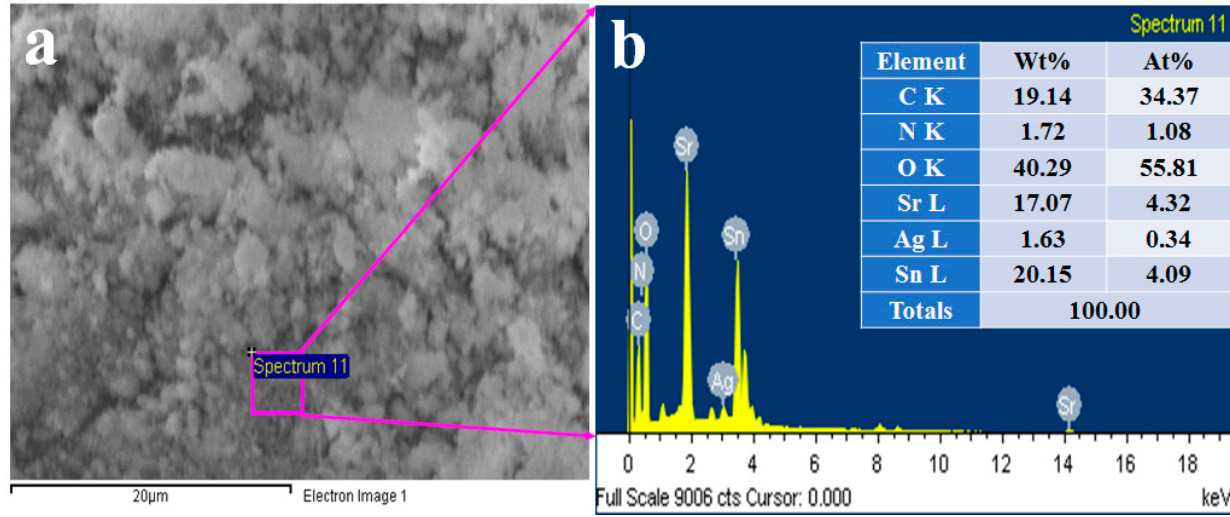
Figure 1. FESEM analysis: ( a ) pure SrSnO 3 , ( b ) Chitosan/SrSnO 3 , and ( c ) Ag-decorated Chitosan/SrSnO 3 NCs.